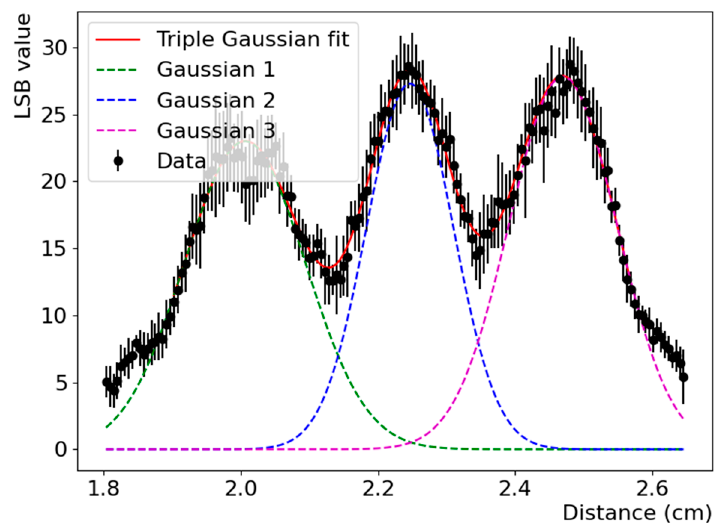
Figure 10. Edge response profile with the GEMPix for 40 kV X-rays obtained using a 2.5 cm-thick lead block. The red line represents a logistic function fit to the data. The signal fluctuations at around 1.4 cm